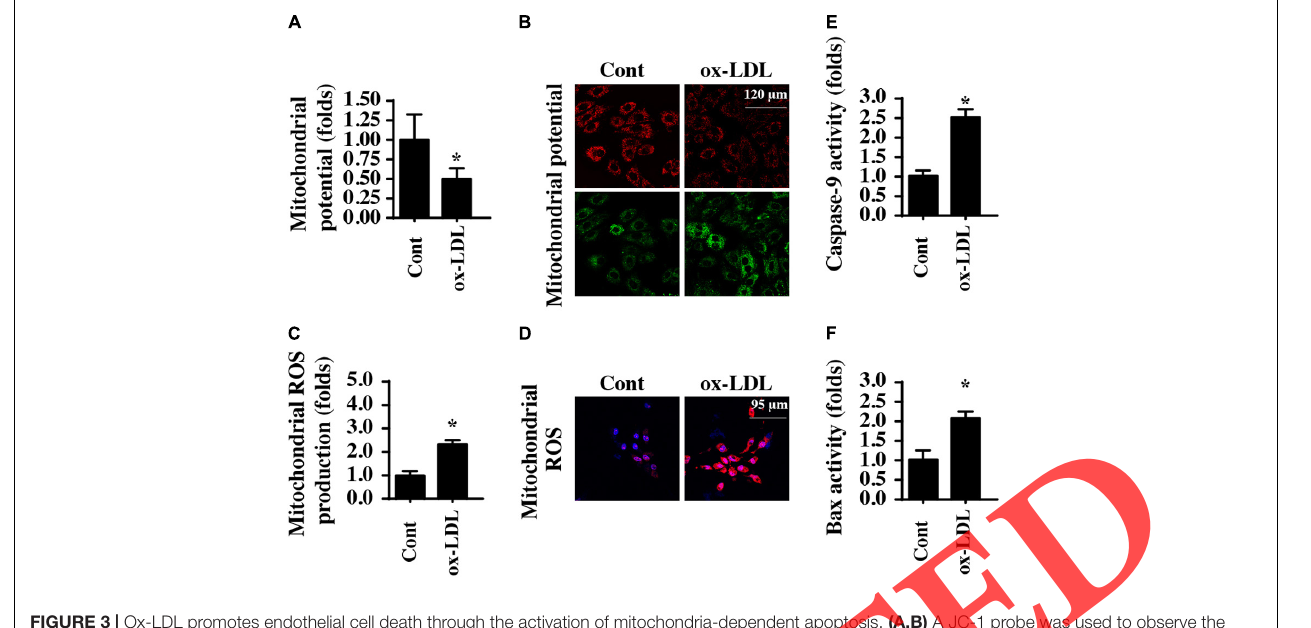
FIGURE 3 | Ox-LDL promotes endothelial cell death through the activation of mitochondria-dependent apoptosis. (A,B) A JC-1 probe was used to observe the mitochondrial membrane potential in endothelial cells after ox-LDL exposure. (C,D) Mitochondrial ROS production was measured through immunofluorescence in ox-LDL-treated endothelial cells. (E,F) An ELISA was used to observe the changes in concentration of capsase-9 and Bax. * p <